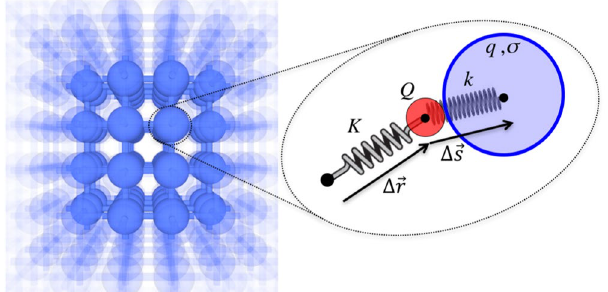
Figure 1. Left panel, ball and stick image of an atomistic model structure. In our scheme, each atomic site is described as shown in the 2D schematics enclosed in the dotted ellipse, i.e. an ionic charge, Q (red disc), and an electronic charge, q (wide blue disc). The ionic charge is connected to an equilibrium position via a harmonic spring K , and the electronic charge is connected to the ion via a harmonic spring k . The electronic charge can be treated either as a spherical shell or a Gaussian distribution of width σ . These parameters are calibrated to reproduce high- and low-frequency dielectric constants of the material